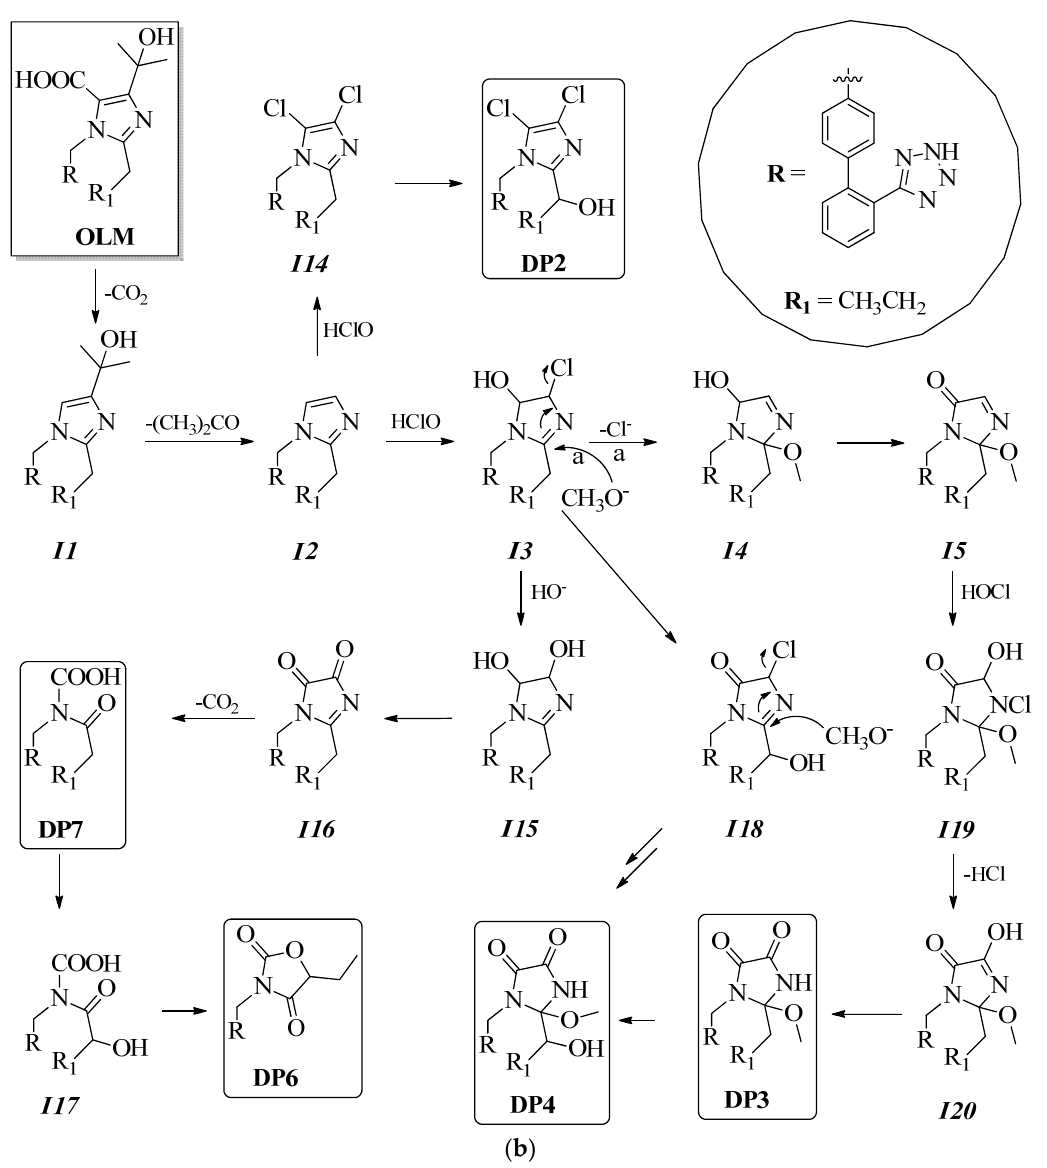
Figure 2. ( a ) Plausible mechanism for the formation of DP1, DP4, DP5, and DP8–DP9. ( b ) Plausible mechanism for the formation of DP2–DP4, DP6–DP7.